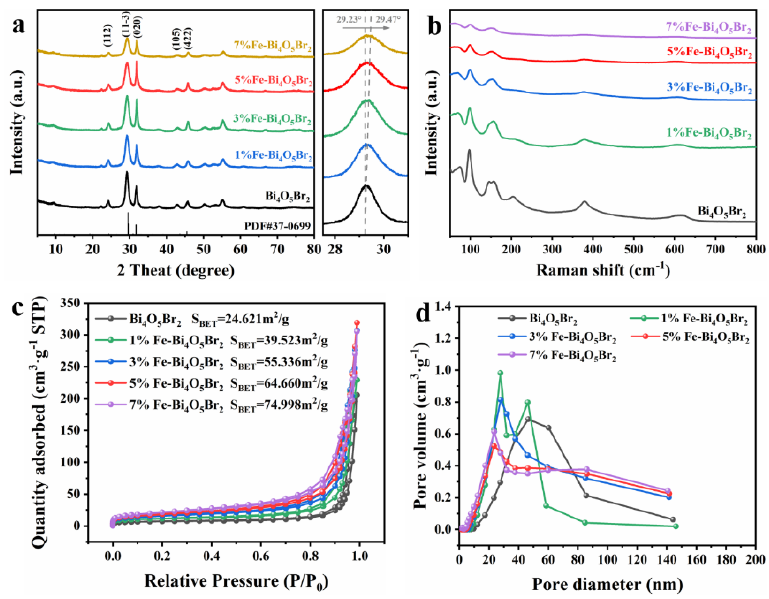
Figure 1. ( a ) XRD patterns, ( b ) Raman spectra, ( c ) N 2 — adsorption desorption isotherm and ( d ) pore size distribution of samples. Table 1. Pore volume and mean pore size of samples.